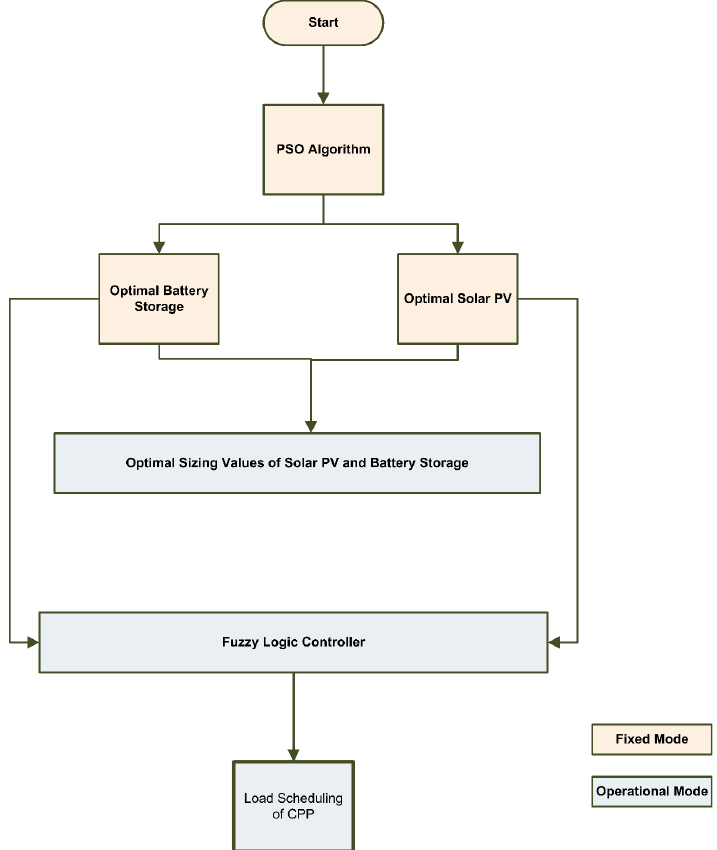
Figure 2. Flow diagram of the proposed integrated algorithm.